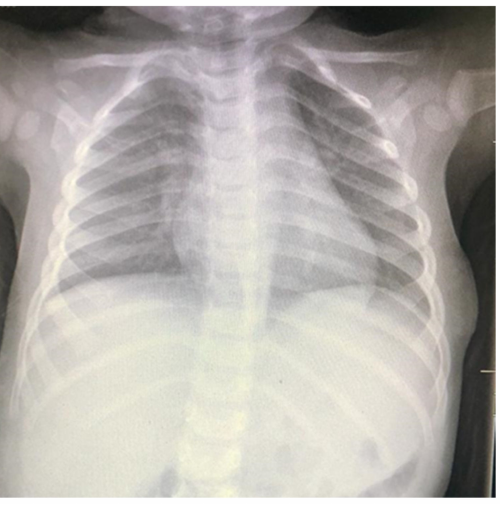
Figure 2. Chest X-ray showing the soft tissue mass with intact ribs.